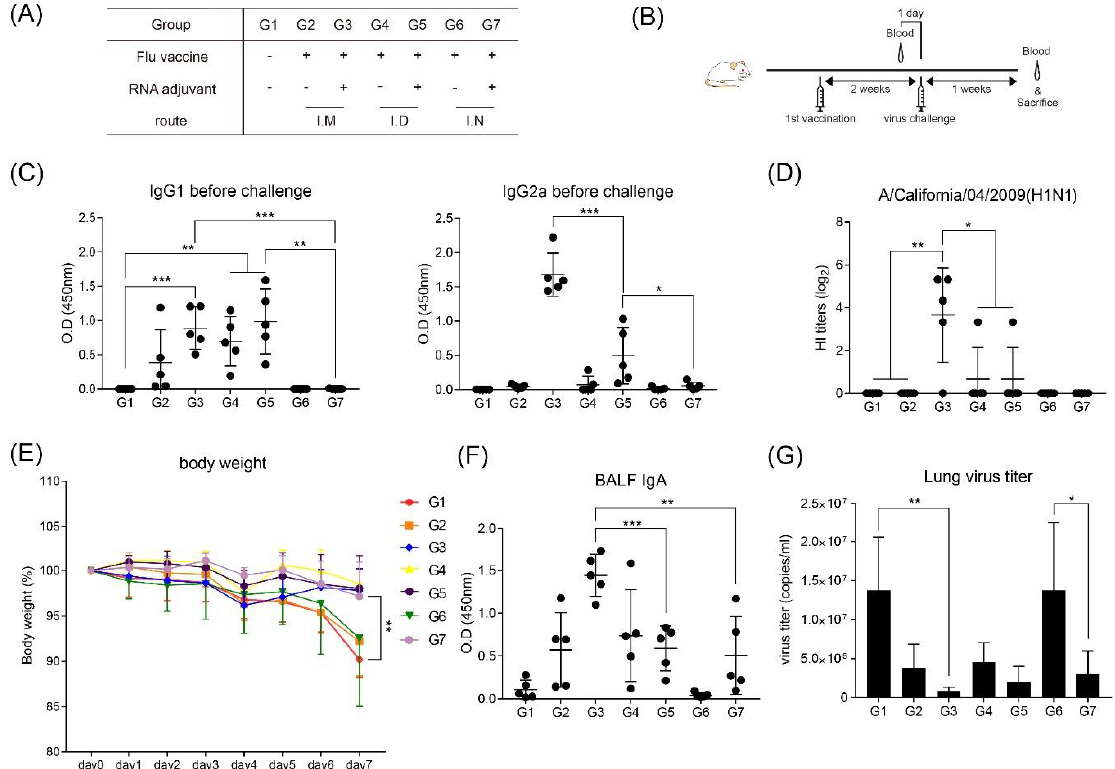
Figure 5. RNA adjuvant formulated influenza vaccine induces humoral immune response and provides protection against viral infections. BALB/c mice were intramuscularly, intradermally, and intranasally immunized with inactivated influenza vaccine with/without RNA adjuvant. ( A ) Overall study design. ( B ) Immunization and virus challenge schedule. ( C ) Influenza vaccine-specific IgG1 and IgG2a levels were measured by ELISA. Serum was collected two weeks after first immunization. ( D ) Hemagglutination inhibition (HI) titer measured by HI assay method. Mice serum was obtained two weeks after first immunization and serially diluted from 1 / 10 to 1 / 1280. ( E ) Measurement of weights changes after virus challenge. ( F ) Influenza-vaccine-specific IgA levels were measured by ELISA. BALF solution was collected one week after influenza virus challenge. ( G ) Virus titer for influenza virus was measured by real-time PCR. Lung tissue was obtained one week after influenza virus challenge. *, p < 0.05; **, p < 0.005; ***, p <